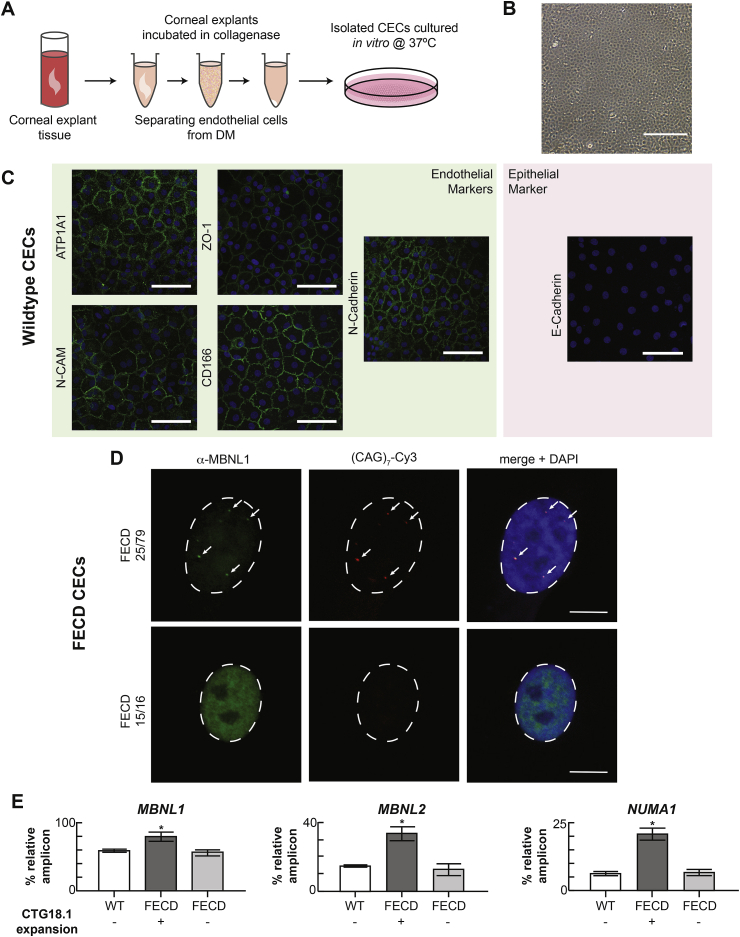
Primary corneal endothelial cell (CEC) cultures provide an in vitro system to model CTG18.1 expansion-associated Fuchs endothelial corneal dystrophy (FECD) and display key biomarkers synonymous with CTG18.1-expansion associated FECD within corneal explant tissue. A. Schematic depicting the approach to culture primary human CECs from corneal explant tissue. B. Phase contrast image of primary CECs in culture displaying hexagonal morphology. Scale bar, 0.4 mm. C. Primary CEC cultures displaying distinctive corneal endothelial polygonal morphology and expressing markers indicative of endothelial cell status. Endothelial markers N-Cadherin, ZO-1, ATP1A1, N-CAM and CD166 were detected and the epithelial marker E-Cadherin was absent in CEC lines derived from healthy explant tissue. Scale bars, 100 μm. D. Representative images of MBNL1 protein nuclear localization in CEC derived from CTG18.1 expansion-positive FECD-affected subjects and CTG18.1 expansion-negative FECD-affected subjects. RNA foci are labelled with a Cy3-(CAG)7 probe and DAPI is used to stain nuclei. Scale bars, 10 μm. E. Aberrantly regulated pre-mRNA splicing events are detected within CTG18.1 expansion-positive primary CECs. Graphs presented represent the mean percentage expression of amplicons of interest relative to total amplified products, per reaction, for each respective group for MBNL1, MBNL2, and NUMA1 transcripts. Error bars represent ±1 standard deviation. P values were calculated by one-way analysis of variance (ANOVA); ∗P < 0.001. Permission for re-use of adapted figure from Zarouchlioti et al., (2018) was granted through CC-BY license (https://creativecommons.org/licenses/by/4.0/legalcode).